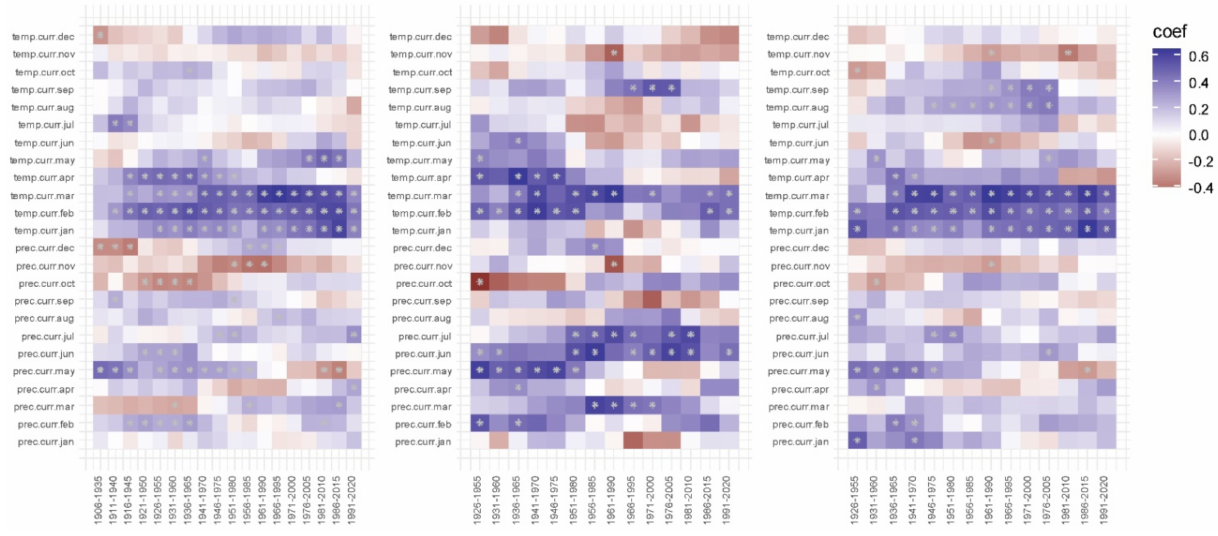
Figure 7. Plot of moving correlation function with 30-year window relating to tree ring growth of Scots pine ( Pinus sylvestris ) ( left ), Norway spruce ( Picea abies ) ( middle ), and Douglas fir ( Pseudotsuga menziesii ) ( right ) to sums of precipitation and mean monthly temperature. Significant correlations ( p < 0.05) are indicated by white